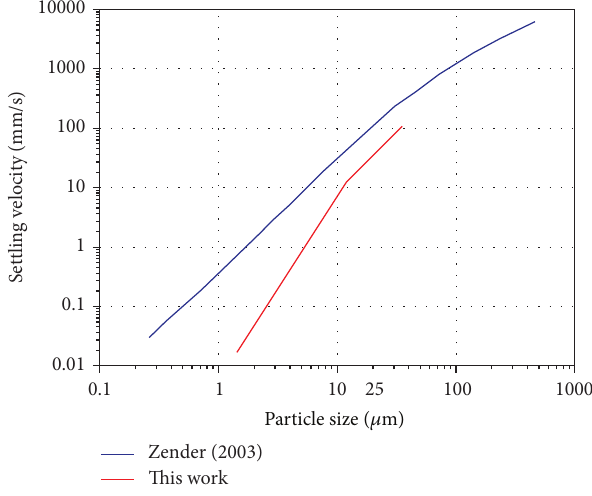
Figure 12: Settling velocity as a function of particle